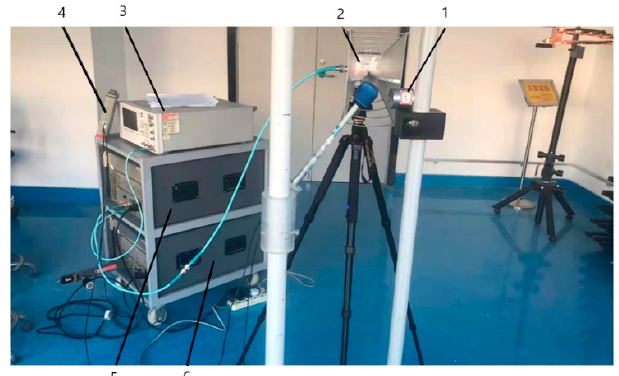
Figure 16. Strong electromagnetic field irradiation experimental device. 1. analog mechatronics product; 2. transmitting antenna; 3. signal transmitter; 4. field strength measurement meter; 5. 0~1 GHz power amplifier; 6. 1~18 GHz power amplifier.